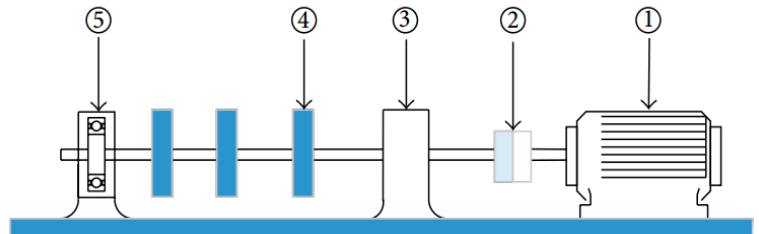
Figure 11. Schematic diagram of the experimental bench system: ① Three-phase asynchronous motor; ② flexible shaft coupling; ③ the bearing with compound fault; ④ bearing rotor; ⑤ the normal bearing.